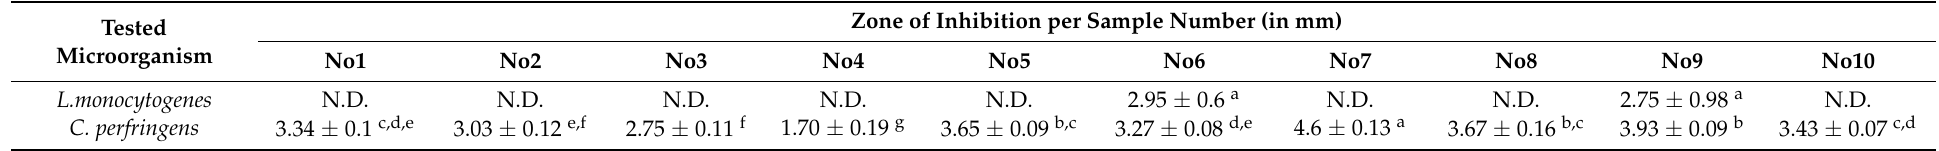
N.D.: not detected; Measured values are medians of three repetitions ± standard deviation; Means that do not share a letter in the same raw are significantly different at p ≤ 0.05 estimated by Tukey Pairwise